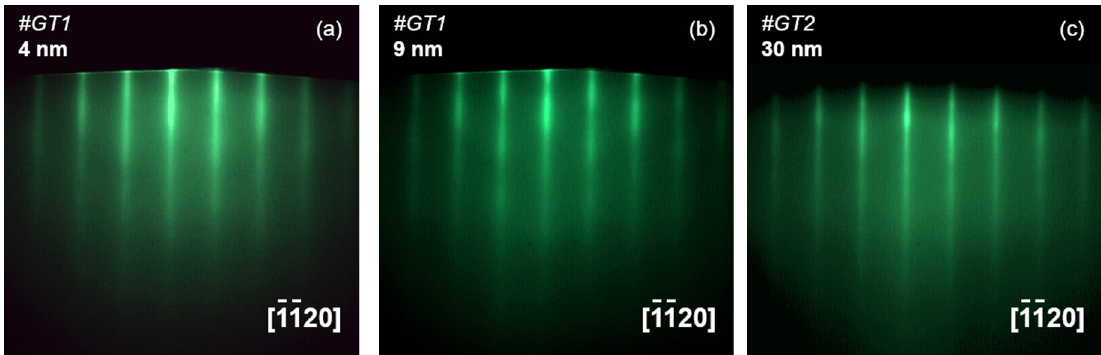
(cid:104) (cid:105) 1120 direction in MBE of GaTe / GaAs(001)